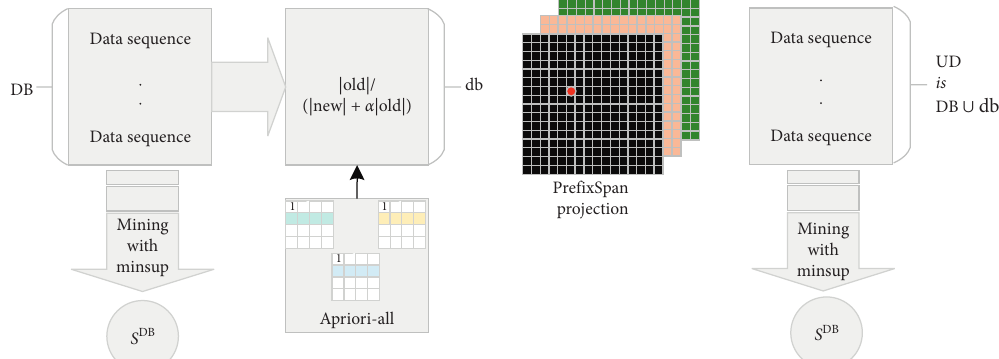
Figure 4: The structure of improved sequential pattern mining